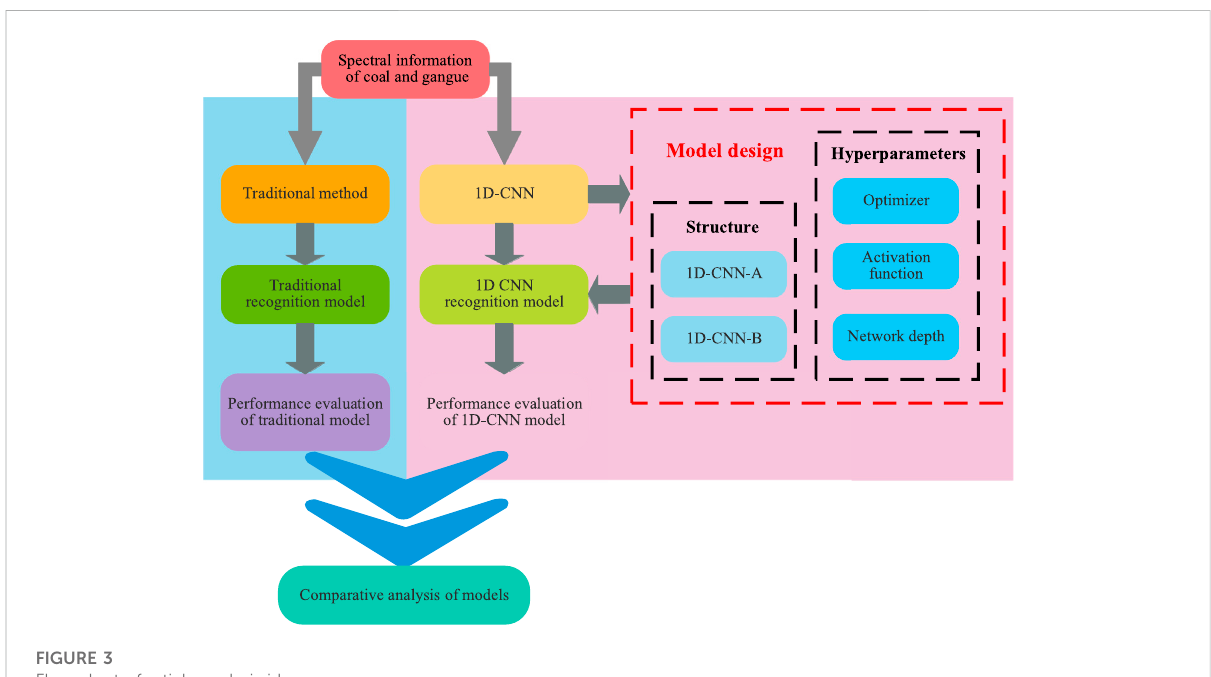
FIGURE 3 Flow chart of article analysis